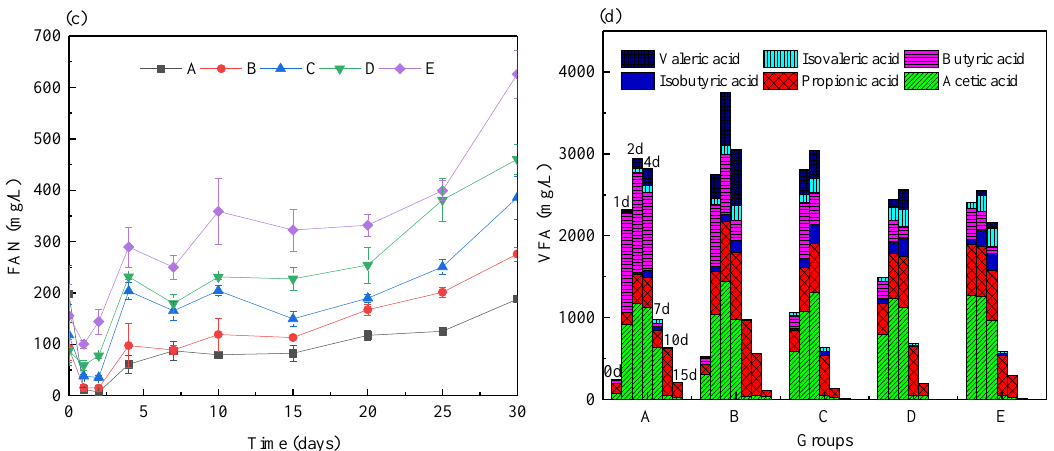
Figure 2. Variations of pH, TAN, free ammonia nitrogen (FAN), and volatile fatty acids (VFAs) during anaerobic codigestion (the mixing ratios of kitchen waste and blackwater based on TS content in groups A–E are 4:0, 3:1, 1:1, 1:3, and 0:4, respectively): ( a ) pH, ( b ) TAN, ( c ) FAN, and ( d ) VFAs.